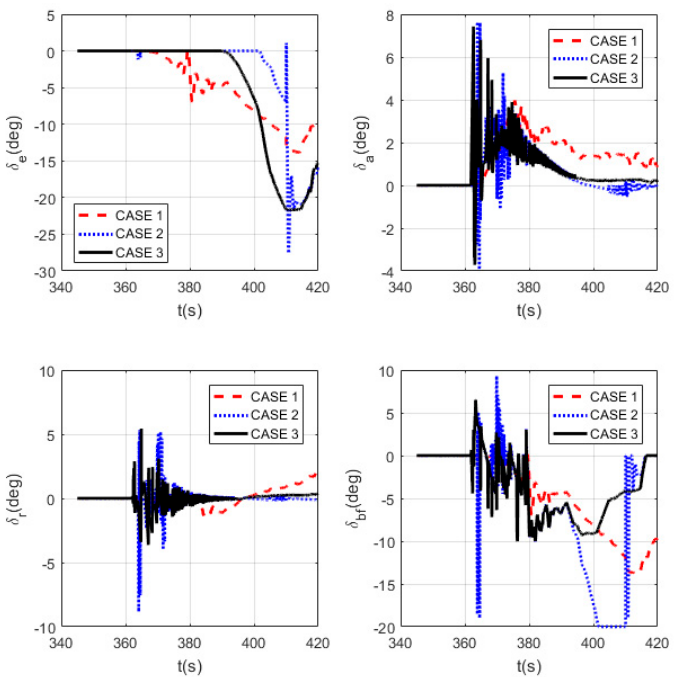
Figure 8. Comparison of the defection angles of the aero surface (AS).